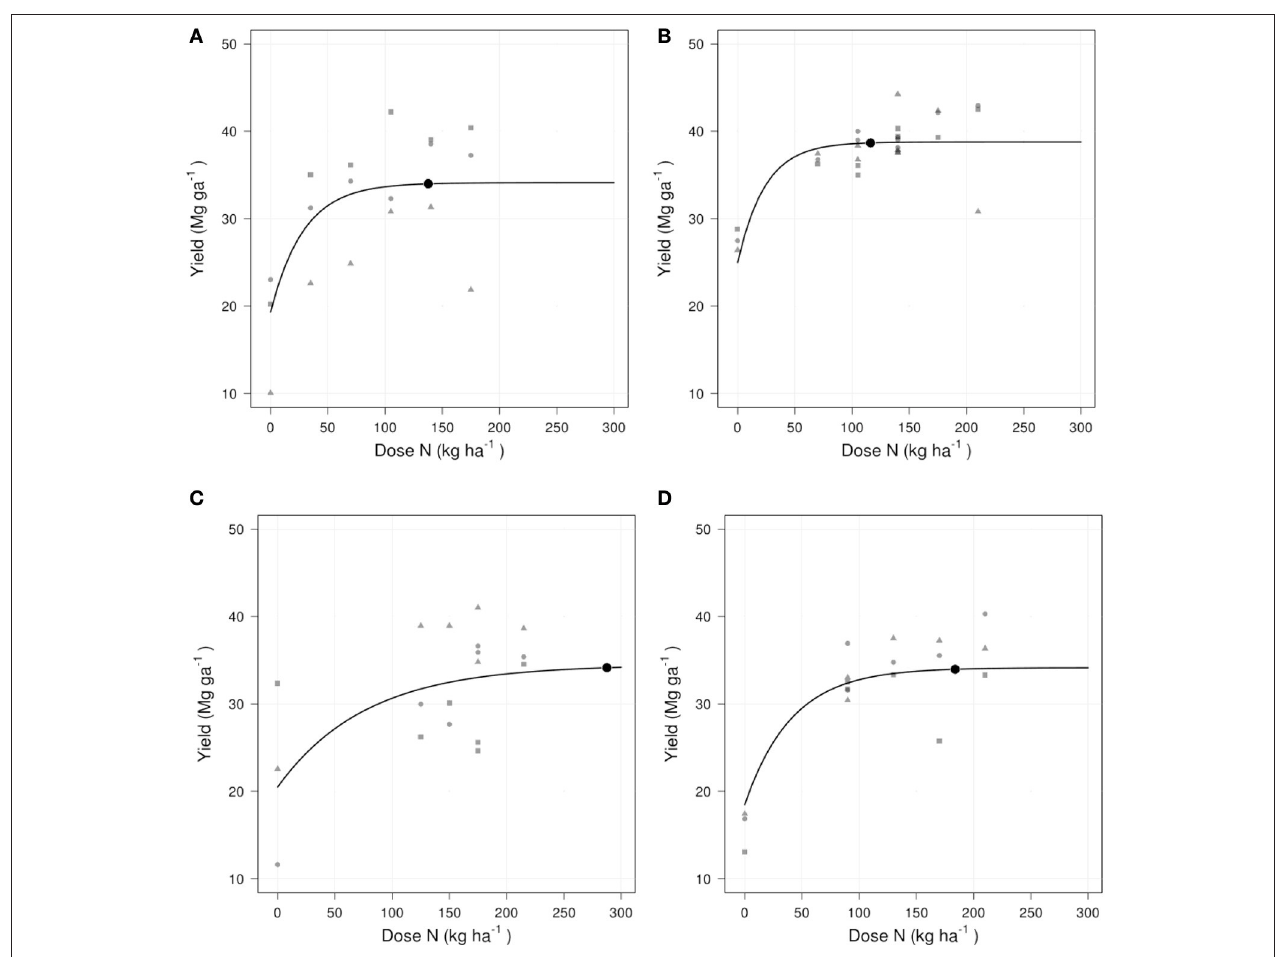
FIGURE 8 | Estimated Mitscherlich curves obtained from the multilevel model. The line is computed from coefficients estimated by the multilevel model. Points are measures, and the symbols represent experimental blocks. Large filled circles are optimal doses and their associated yield. (A) Trial 4, (B) Trial 71, (C) Trial 157, and (D)